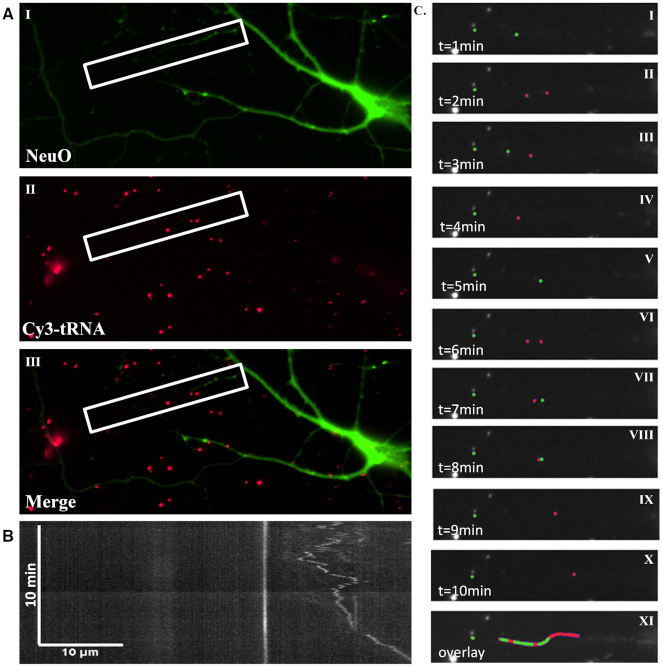
tRNA is bi-directionally transported in dendrites. (A) Still image capture of live neurons. Images of neuronal co-culture stained with NeuO NeuroFluor live neuronal dye and transfected with Cy3-tRNA (I – NeuO, II – Cy3-tRNA, III – merge). (B) tRNA is transported in dendrites. Kymograph of tRNA movement within dendrites over a 10-minute period. Images acquired at 6-second intervals. (C) tRNA in dendrites is transported in both anterograde and retrograde directions. (I–X) Representative captures of displacement of tRNA puncta in 1-minute intervals over a period of 10 min. tRNA puncta are represented in red or green, depending on the direction of movement along the dendrite. (XI) Overlay of images I–X.